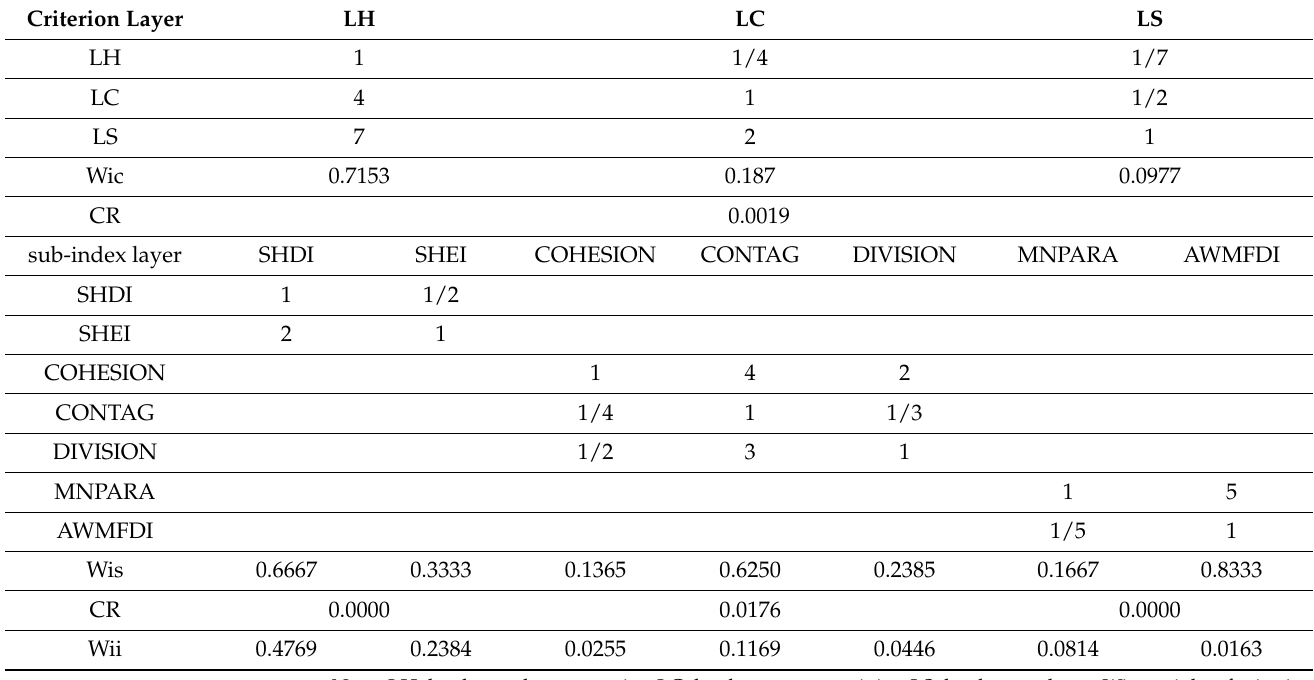
Table 1. Weights of criterion and sub-index layers of ecosystem organization using AHP.